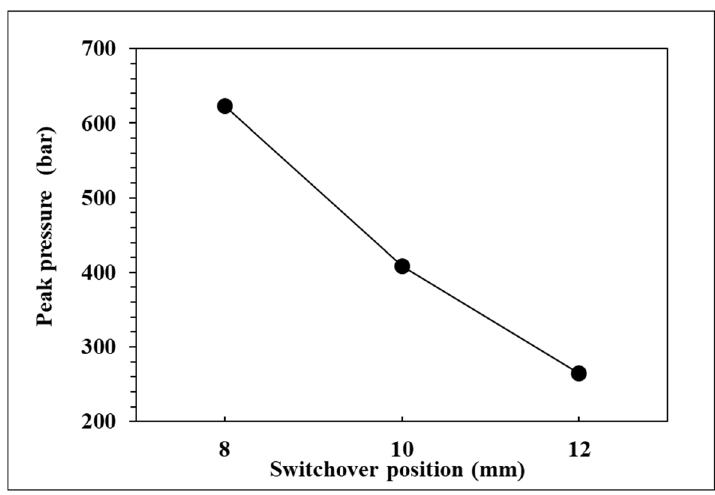
Polymers 2022 , 14 , x FOR PEER REVIEW Figure 10. Relationship between peak pressure and switchover position . Figure 10. Relationship between peak pressure and switchover position . Figure 10. Relationship between peak pressure and switchover position.